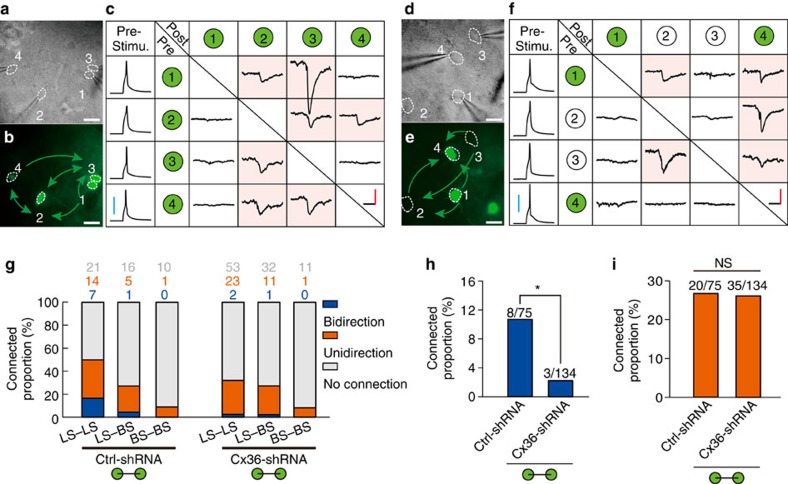
Electrical coupling is required for the formation of bidirectional chemical synapses between layer 1 interneurons.(a–f) Quadruple whole-cell recordings of four layer 1 interneurons in a Ctrl-shRNA (a–c) and Cx36-shRNA (d–f) slice. DIC (a,d) and fluorescence images (b,e) of the respective quadruple whole-cell recordings are shown. The green arrows in b and e indicate the direction of chemical synapses. A summary of the chemical synaptic connections detected in the quadruple recordings is also shown (c,f). Pink shading indicates the existence of chemical synapses. Scale bar, 20 μm in (a,b,d,e), 20 pA (red), 40 mV (blue) and 15 ms (black) in (c,f). ‘Pre-Stimu.', presynaptic potential; ‘Pre', presynaptic neuron; ‘Post', postsynaptic neuron. (g) Summary of the proportion of chemical synapse formation between layer 1 interneurons in Ctrl-shRNA (GFP+-GFP+ pairs) and Cx36-shRNA (GFP+-GFP+ pairs) slices at P9–P25. Green circle indicates GFP+ cells. (h) The proportion of bidirectional chemical connections in Cx36-shRNA group was significantly less than in Ctrl-shRNA groups. (i) The proportion of unidirectional chemical connections in Ctrl-shRNA and Cx36-shRNA groups showed no significant differences. n=21 mice for Ctrl-shRNA group, 37 mice for Cx36-shRNA group. *P<0.05, n.s., not significant, P>0.05. χ2-test, Fisher's exact test.